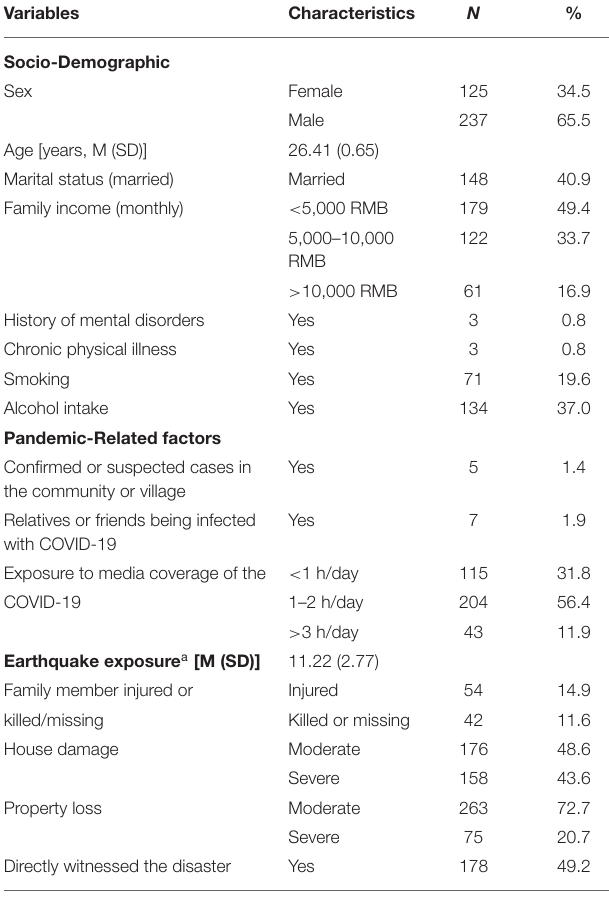
TABLE 1 | Sample characteristics and trauma